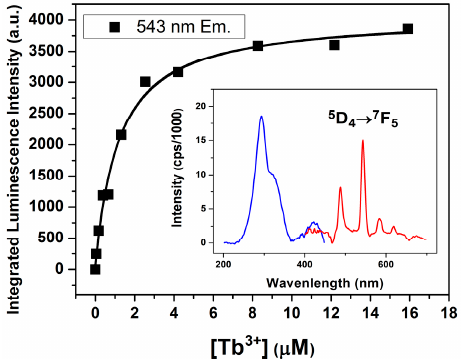
Figure 4. Tb 3+ binding to the DNA 4WJ measured by luminescence. Titration of TbCl 3 into 10 µ M junction leads to an increase in Tb 3+ luminescence at 543 nm. Excitation was done at 294 nm to excite the DNA and the luminescence peak at 543 nm is only observed in the presence of Tb 3+ and junction. ( Inset ) Excitation and emission spectra of the Tb luminescence; the 5 D 4 → 7 F 5 transition at 543 nm is highlighted.